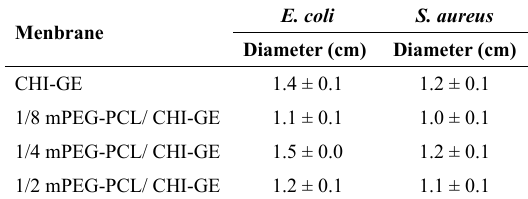
Table 6. Diameter of the zone of inhibition (cm) around gentamicin loaded membranes against E. coli and S.